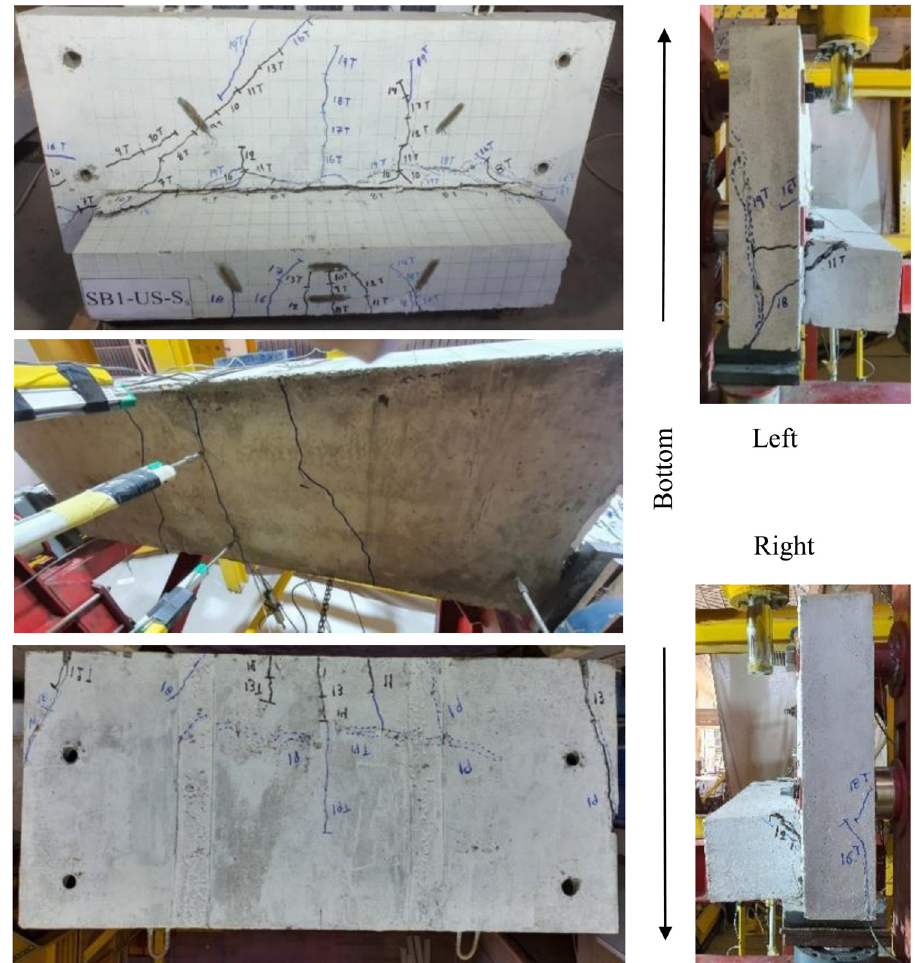
Figure 9: Cracking pattern and failure mechanism of L - spandrel